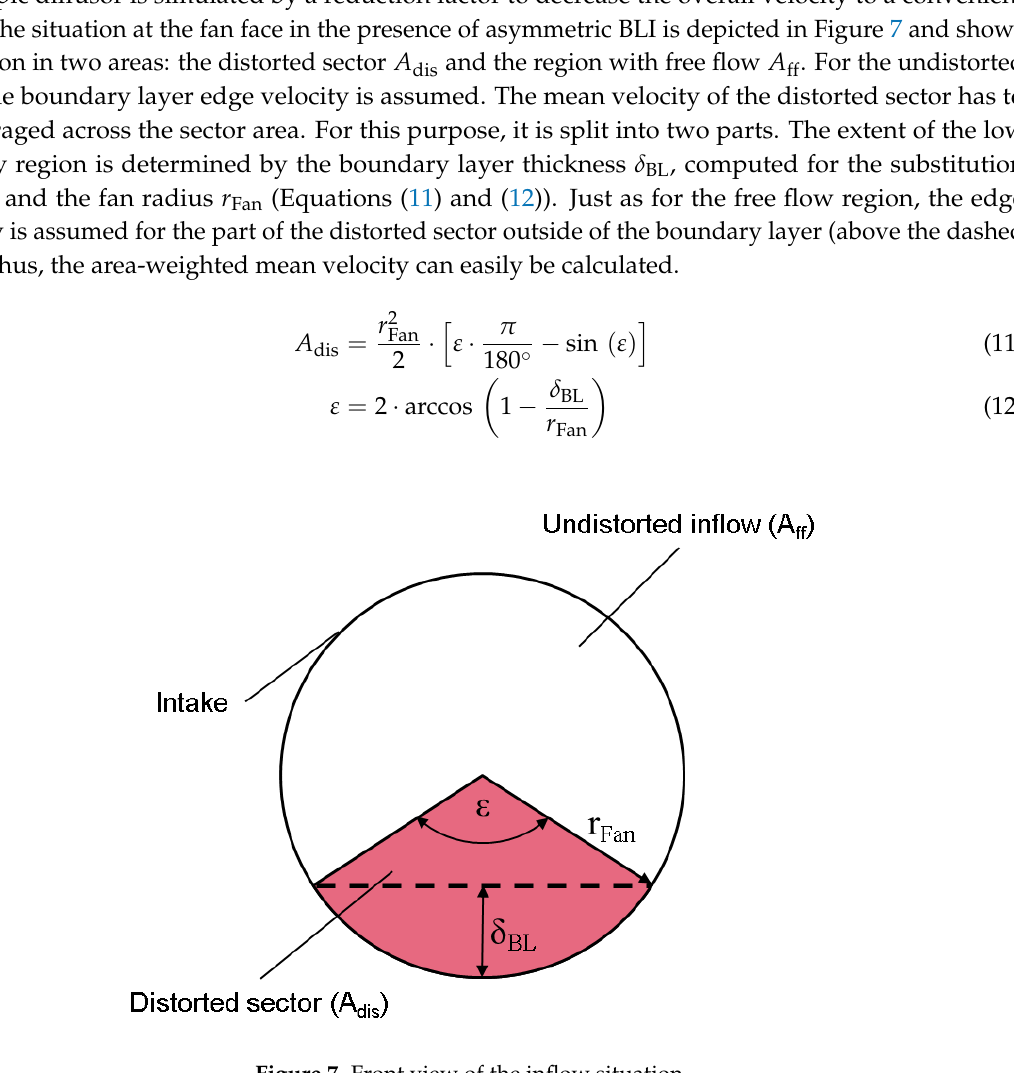
Figure 7. Front view of the inflow